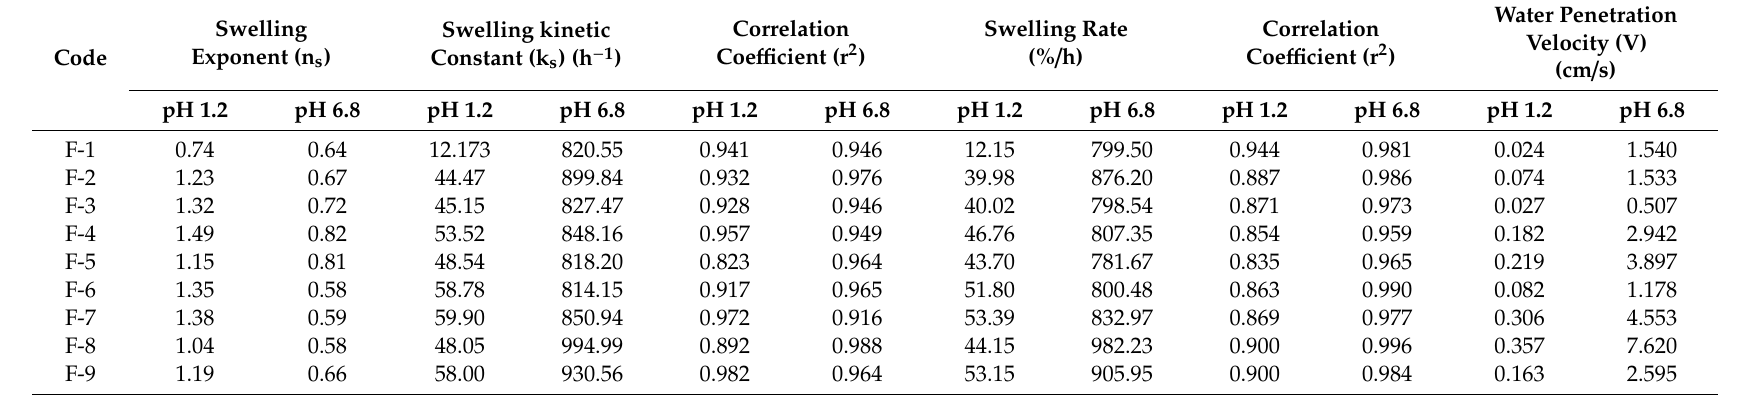
Table 3. Swelling parameters (exponent, ns and kinetic constant, ks), swelling rate and water penetration velocity (up to 1 h) of various beads in acidic and alkaline